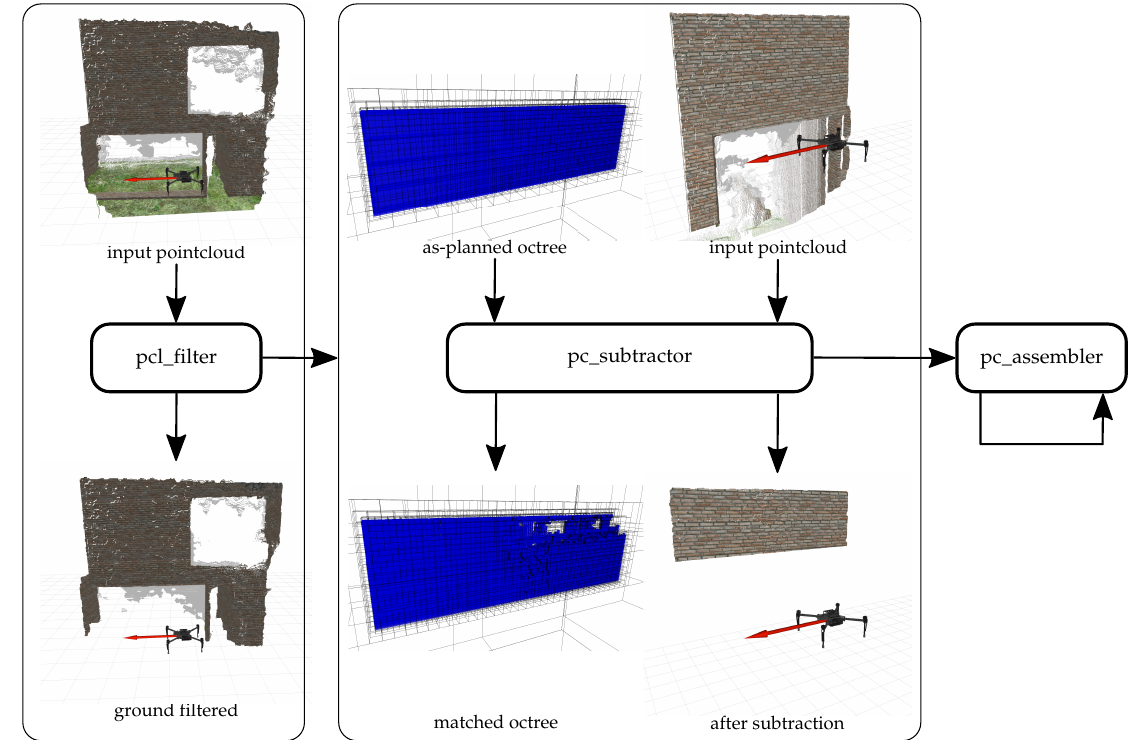
Figure 4. Components of the point cloud processing subgroup. The pcl_filter removes all points at ground-level. The pc_subtractor processes the incoming point cloud with the as-planned octree from the BIM. It generates a matched octree with with occupied cells where physical surfaces were detected. The second output is the object point cloud that represents the target object. The pc_assembler optionally collects all subtracted point clouds and accumulates them for complete